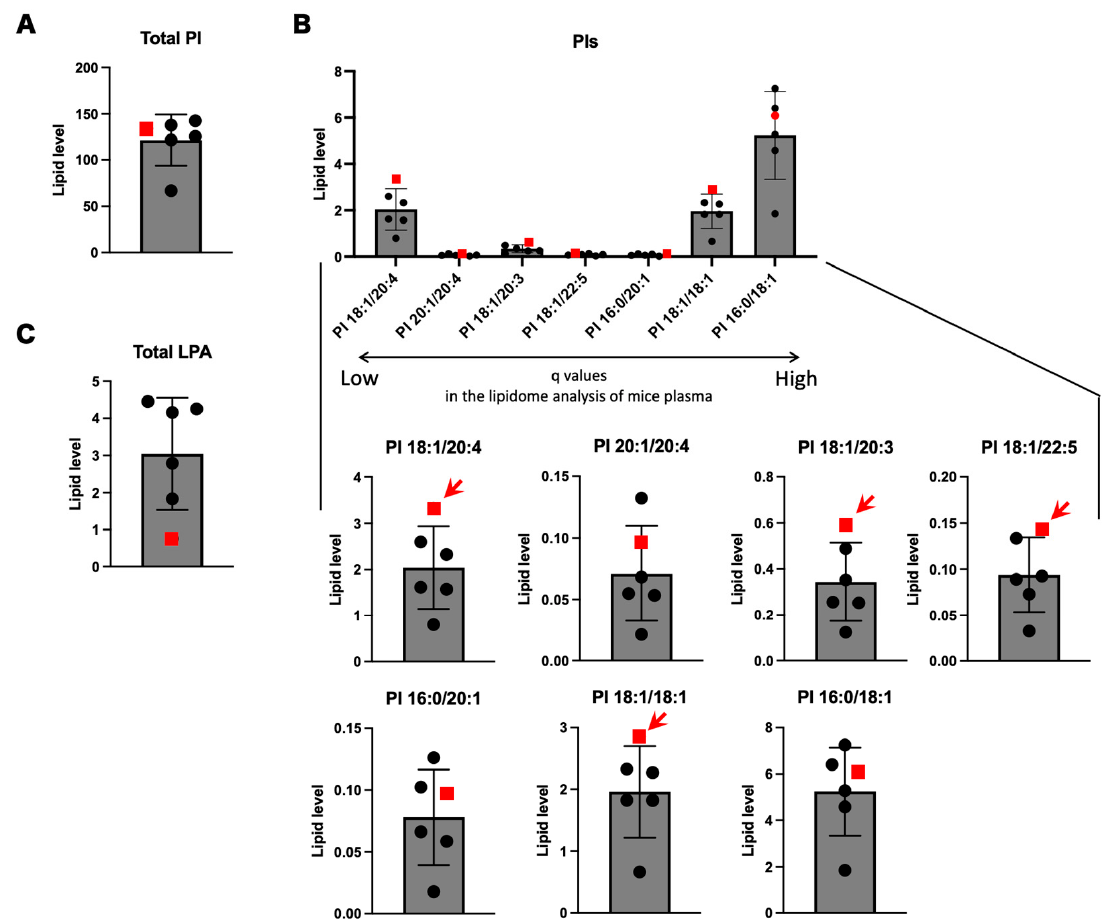
Figure 4. Lipidome analysis using human sera of the SPG28 patient and five controls. ( A ) Total PIs in human sera. ( B ) Focused analyses of human sera on PI species significantly changed in Ddhd1 ( − / − ) plasma from mice. PIs arranged in the order of decreasing q values obtained from lipidome analysis using plasma from mice. Individually enlarged charts are shown below. Red arrows indicate the PI species with the highest levels in the SPG28 patient. ( C ) Total LPAs in human sera. The data points of SPG28 are represented by red squares. The unit of the vertical axis is